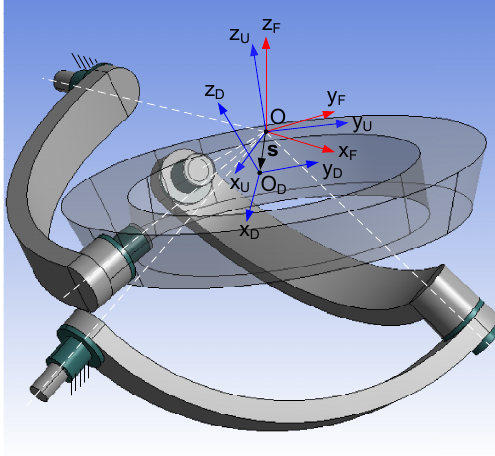
Figure 1. Frames attached to the BP { F } , to the MP in the unde- formed configuration { U } and to the MP in the deformed configura- tion { D }